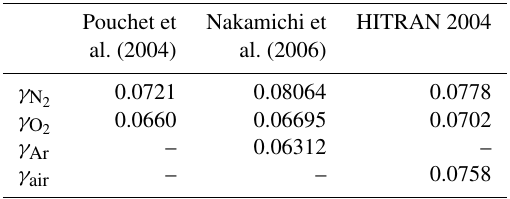
Table 6. Pressure broadening for investigated gas mixtures based on pressure broadening coefficients from different sources.